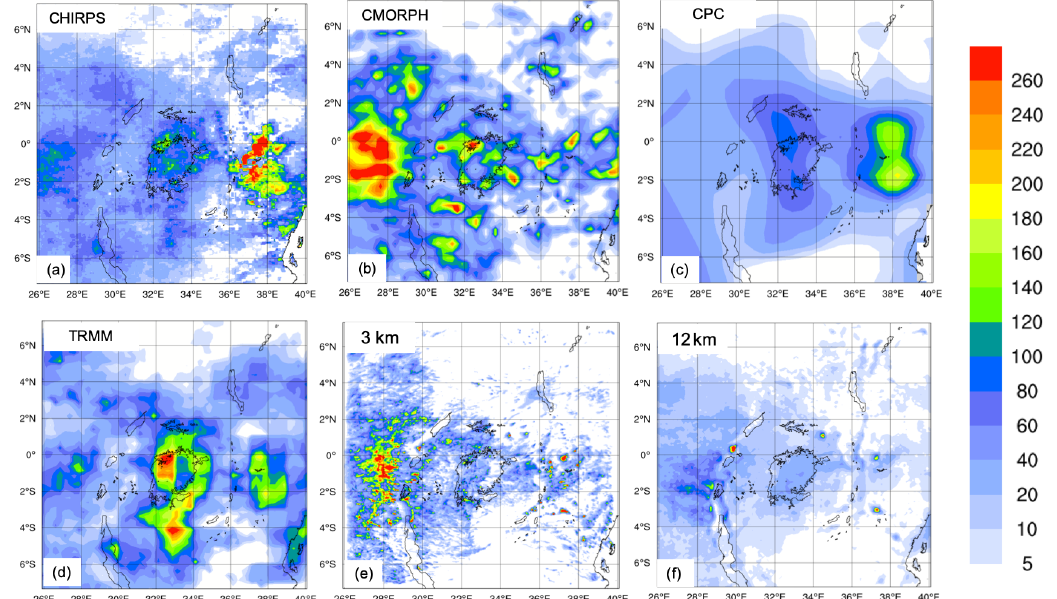
Figure 11. Total event accumulated precipitation (mm) during the LKV case (25 November 1999–1 December 1999) measured by CHIRPS (a) , CMORPH (b) , CPC (d) and TRMM (e) and calculated by RegCM4 at 3km (e) and 12km (f)